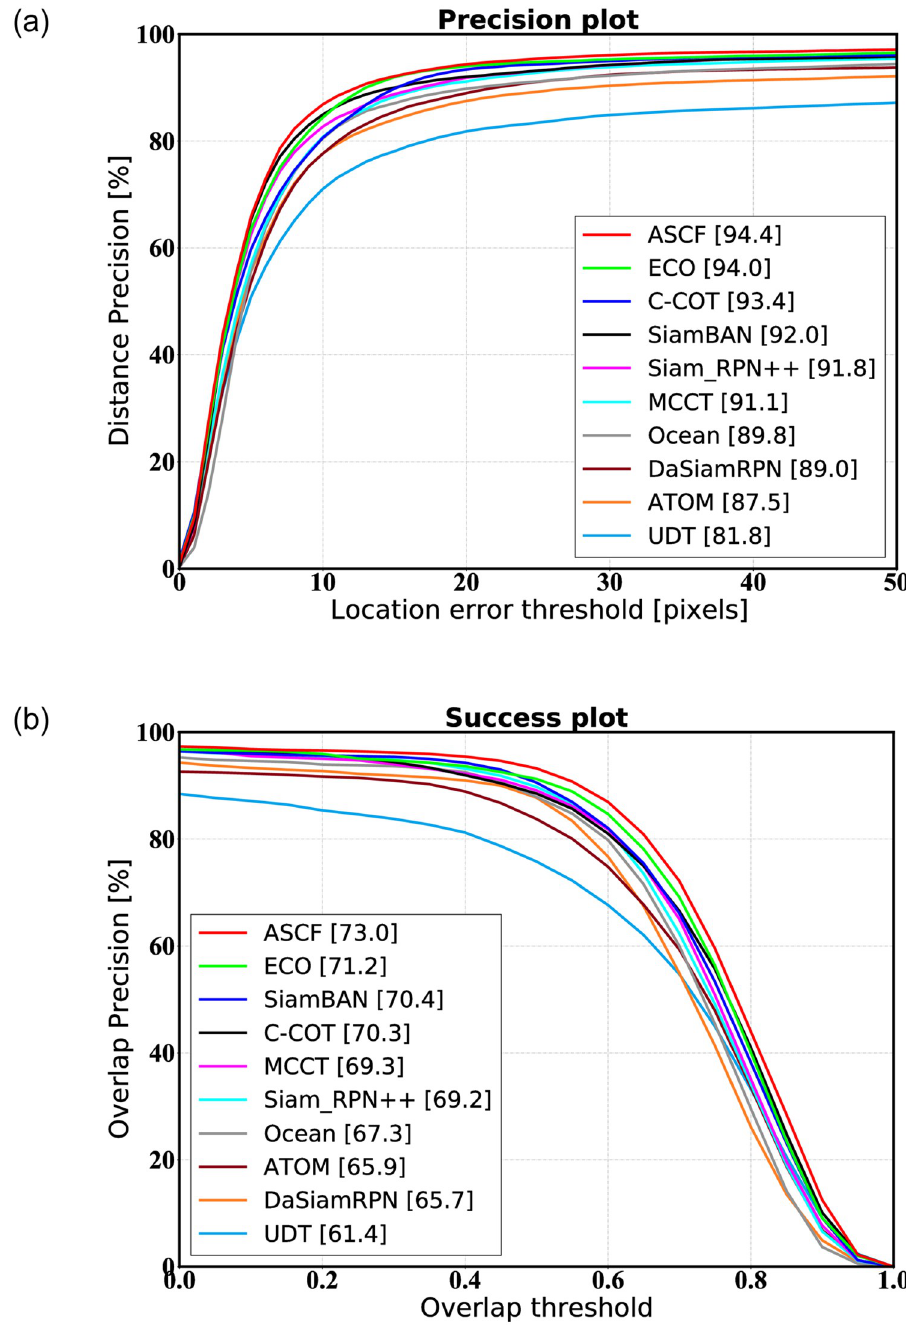
Fig 4. One-pass evaluation, the distance accuracy DP of the tracker and the area under the overlap rate curve accuracy AUC are displayed on the OTB-2013 data set, and the center position error CLF score threshold of the distance accuracy DP is set to 20. (a) OTB2013 (DP). (b) OTB2013 (AUC).